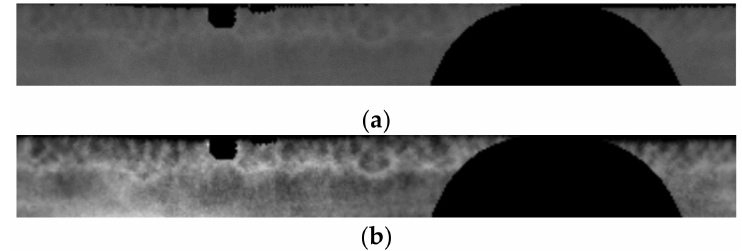
Figure 9. Unrolled iris pattern: ( a ) before contrast enhancement; ( b ) after contrast